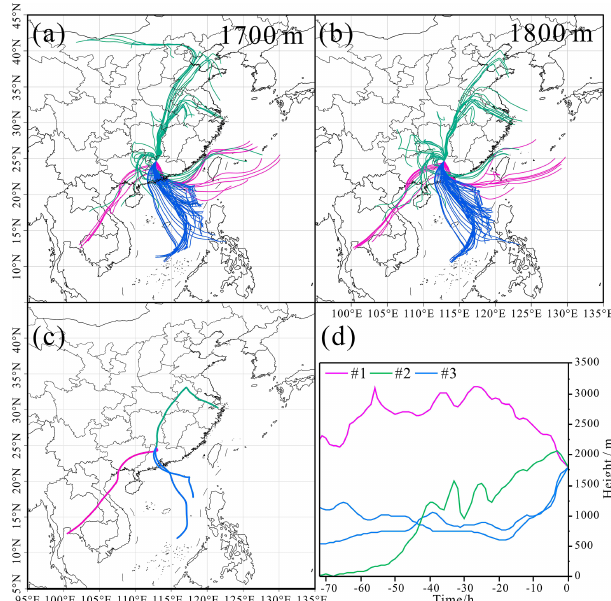
Figure 4. HYSPLIT back trajectories (72h) for air masses arriv- ing at our sampling site at the height of 1700m (a) and 1800m (b) hourly during the three cloud events. The HYSPLIT back trajecto- ries at the height of 1800m during sampling periods (c) and heights (above sea level) of the air masses during transport (d) . The hori- zontal axis represents several time points (0–72h) before the time point input into the HYSPLIT